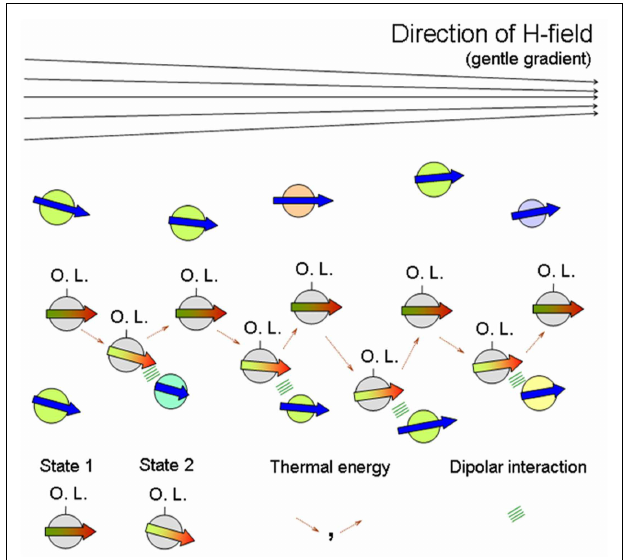
FIGURE 3 | Speculated asymmetric interactive diffusion in aqueous medium of further incoming organic ligand (O.L.)-linked MNPs – indicated by red-green arrows – through a field-induced MNP aggregate – indicated by blue arrows – in response to a gentle gradient (say, non-homogeneous rock field). Here particles comprising the MNP-aggregate could have differences in associated magnetic moment size (see blue arrow length), diameter, composition (see circle-colour – green, blue, yellow, pink), etc. State 1/ State 2 correspond to lower/higher template-affinity states of the diffusing O.L.-linked MNP, indicated by a grey circle having darker/brighter red-green coloured arrow, respectively. A spatially non-homogeneous H-field (direction indicated on top) provides both detailed-balance breaking non-equilibrium and asymmetry, to a diffusing magnetic dipole undergoing infinitesimal spin-alignment changes. In addition to the external field and the bath fluctuations, its orientational state is influenced by the local H-fields of its “template” partners (forming the aggregate) that would periodically perturb its directed diffusion; this magnetic interaction in State 2 is represented by green lines.Thus the dipole’s magnetic d.o.f. would enable alternating unbound and bound states, like isothermal release/attachment cycles of molecular machines on nucleic acid/protein templates, respectively.These changes would be similarly facilitated by thermal excitations from bath – indicated by dotted brown arrows – with rectification by either the gentle H-field gradient or local template-partner H-fields (Mitra-Delmotte and Mitra 2010a; see